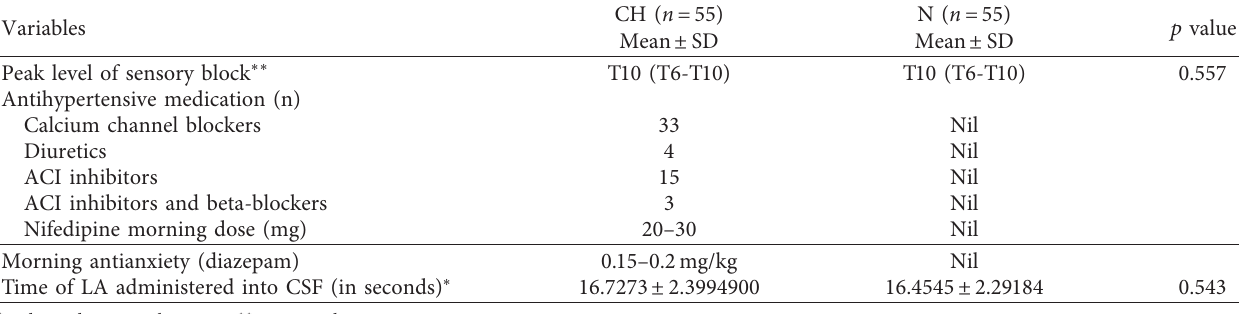
Table 2: Comparison of the peak level of sensory block and preoperative medication use between the two groups: at Black Lion Hospital from October 30, 2019, to January 30, 2020.